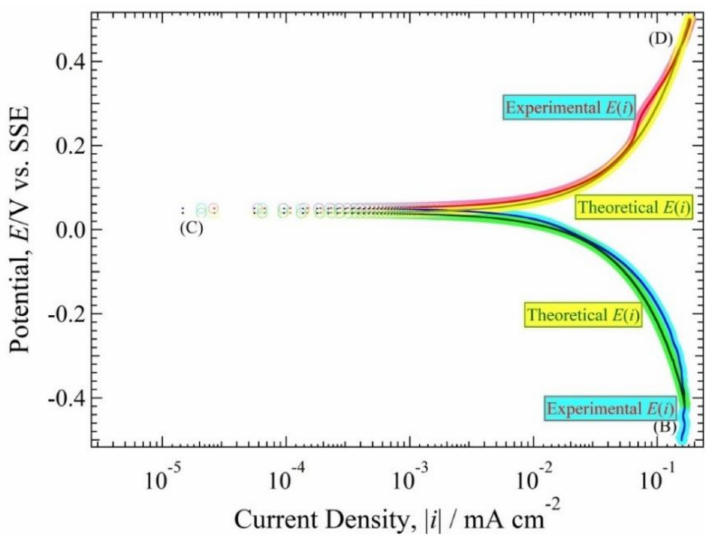
Figure 13. Superimposition of the experimental polarization curve and theoretical polarization curve obtained by solving the polarization resistance